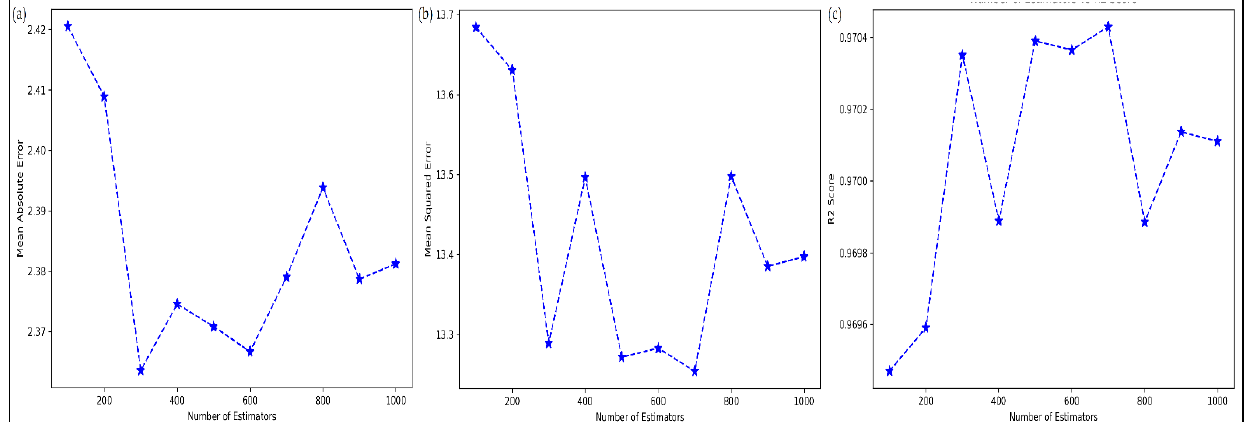
Figure 3. Effect of number of estimators on random forest regression’s performance in terms of ( a ) MAE, ( b ) MSE and ( c ) R 2 .